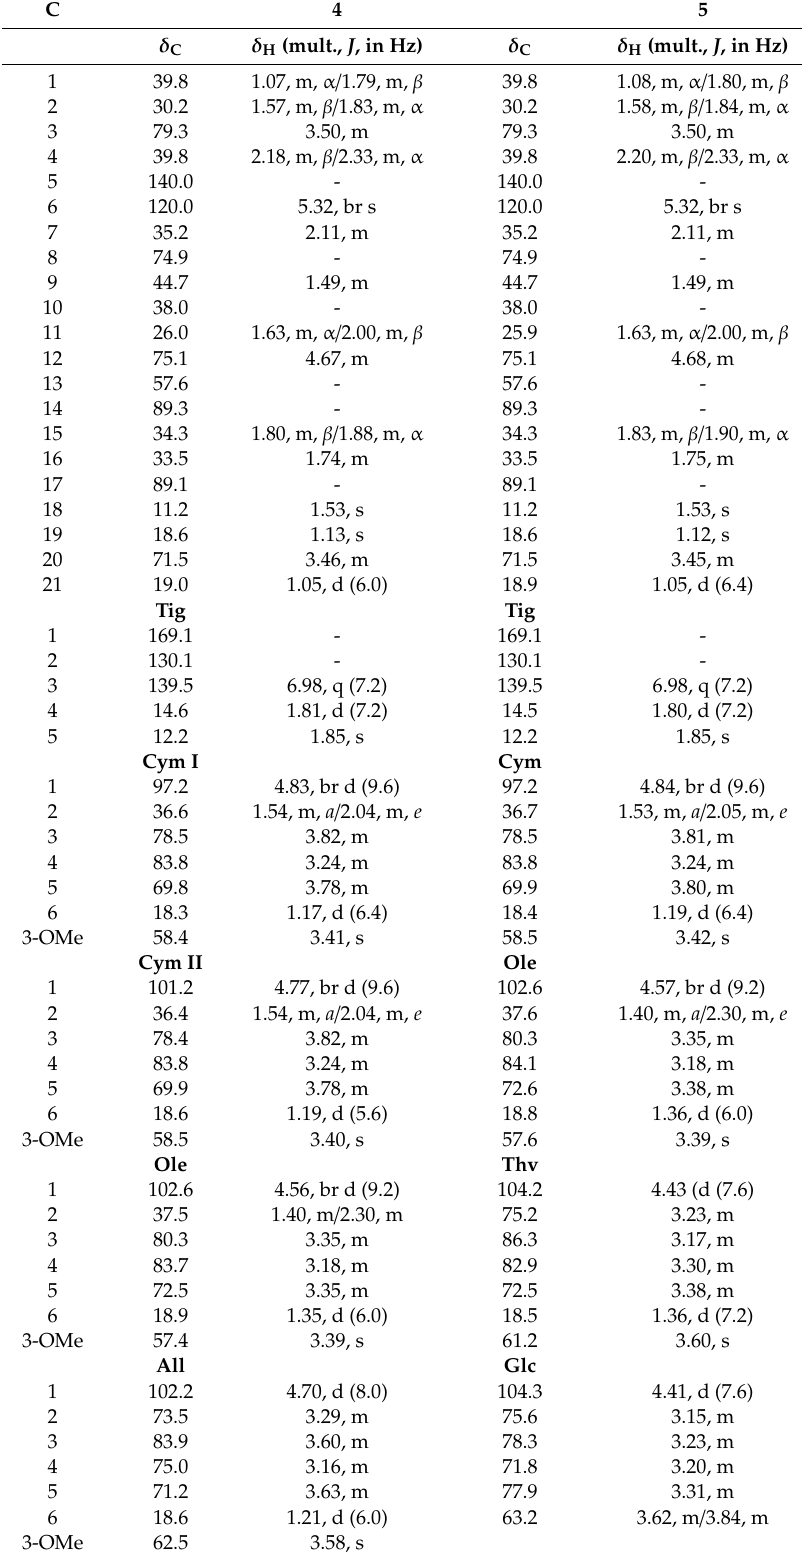
Table 2. NMR spectroscopic data for compounds 4 and 5 in CD 3